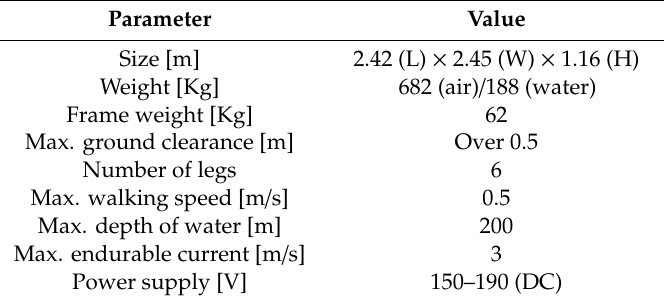
Table 2. Specification of the CR200.